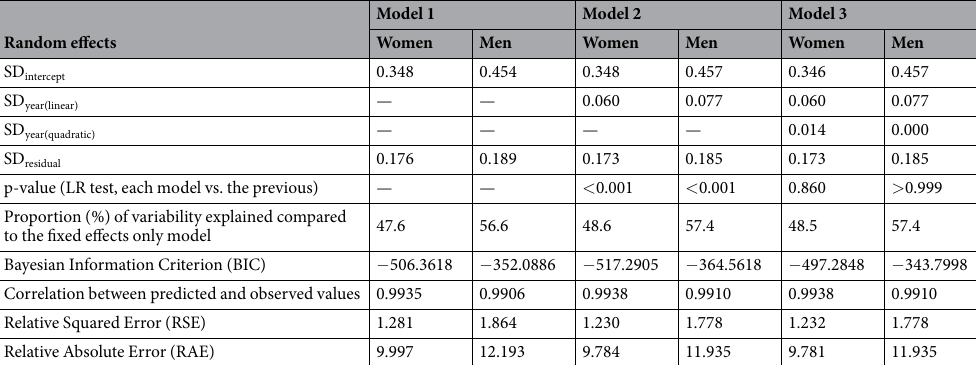
Table 2. Summary of the adjustment of mixed effects models, including random effects for country, to observed hip fracture incidence rates. SD - standard deviation; LR - likelihood ratio. Model 1: random intercept. Model 2: Model 1 + random linear term for calendar year. Model 3: Model 2 + random quadratic term for calendar